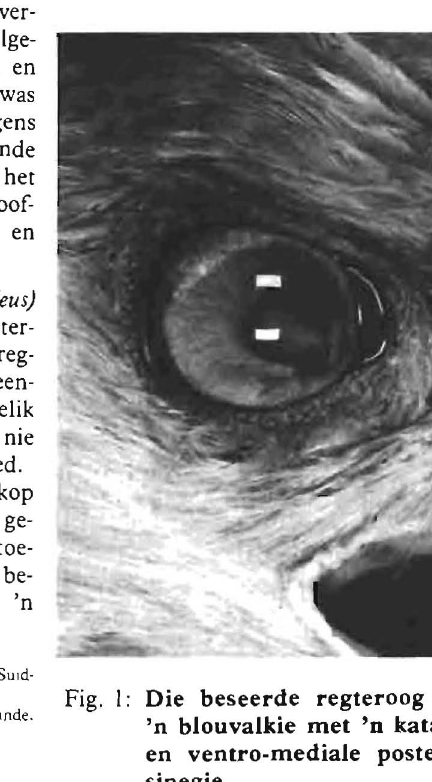
Fig. I: Die beseerde regteroog